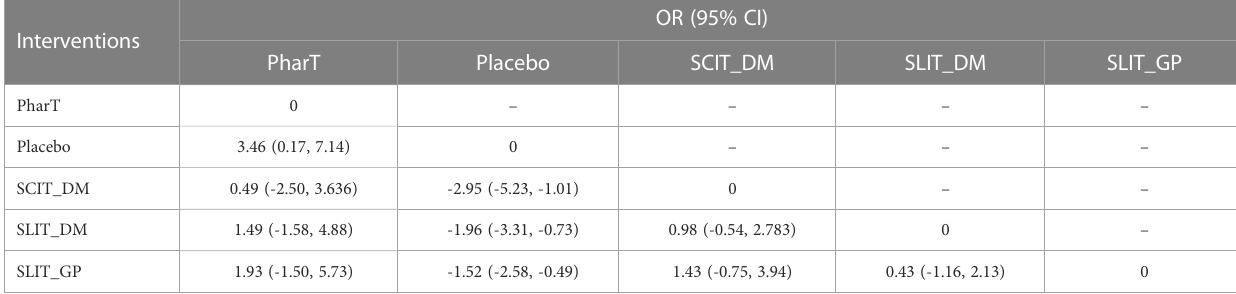
TABLE 3 Network meta-analysis of adverse